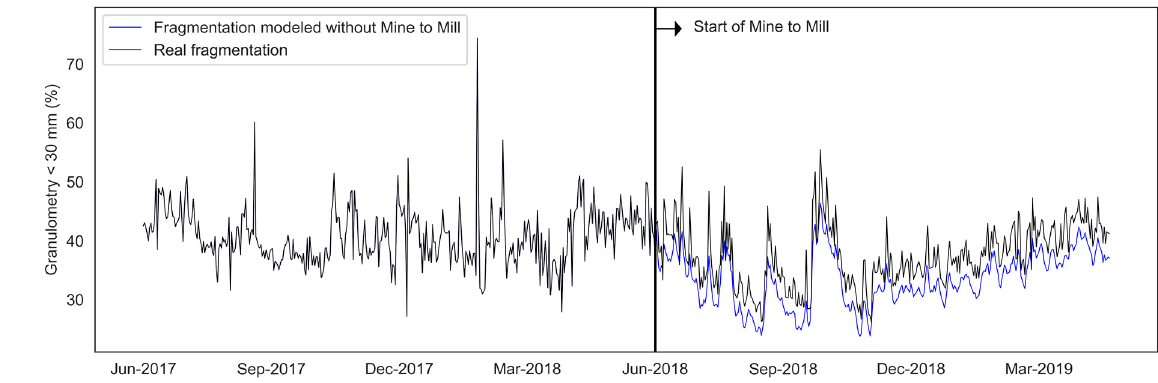
Figure 5. Daily average fragmentation of mineral feeding in an SAG mill.